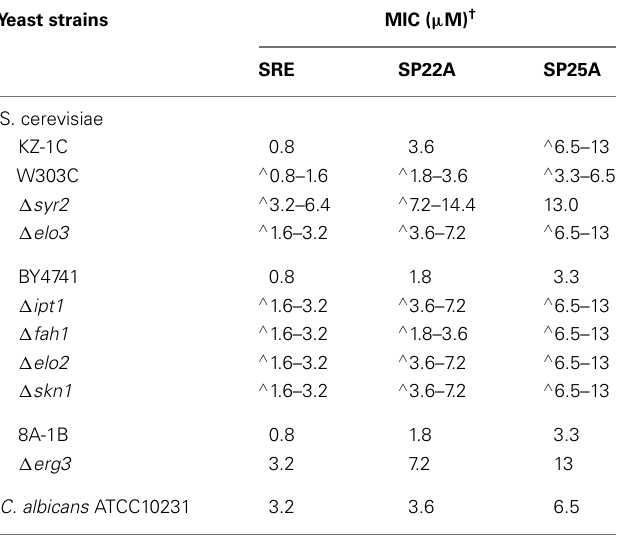
Table 1 | Minimal inhibitory concentrations (MICs) of SRE, SP22A, and SP25A against S. cerevisiae strains, lipid biosynthetic mutants, and C. albican sATCC10231.